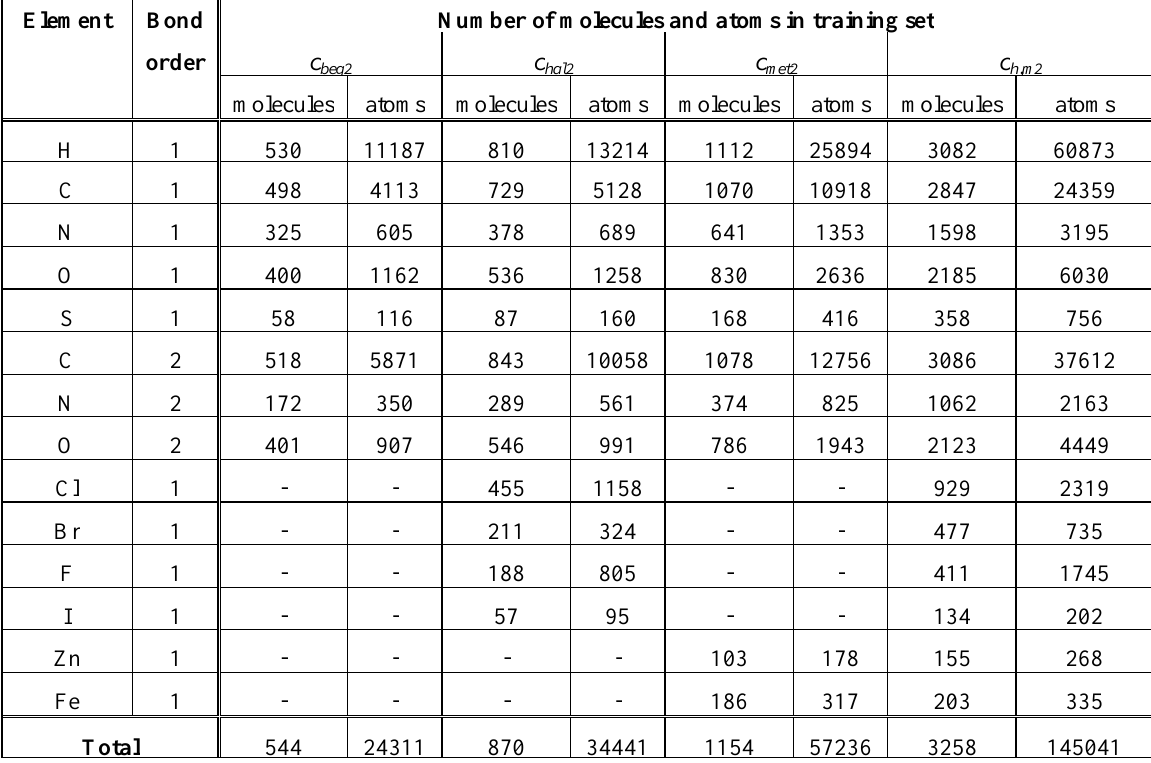
and c . For more details see the c met2 h,m2